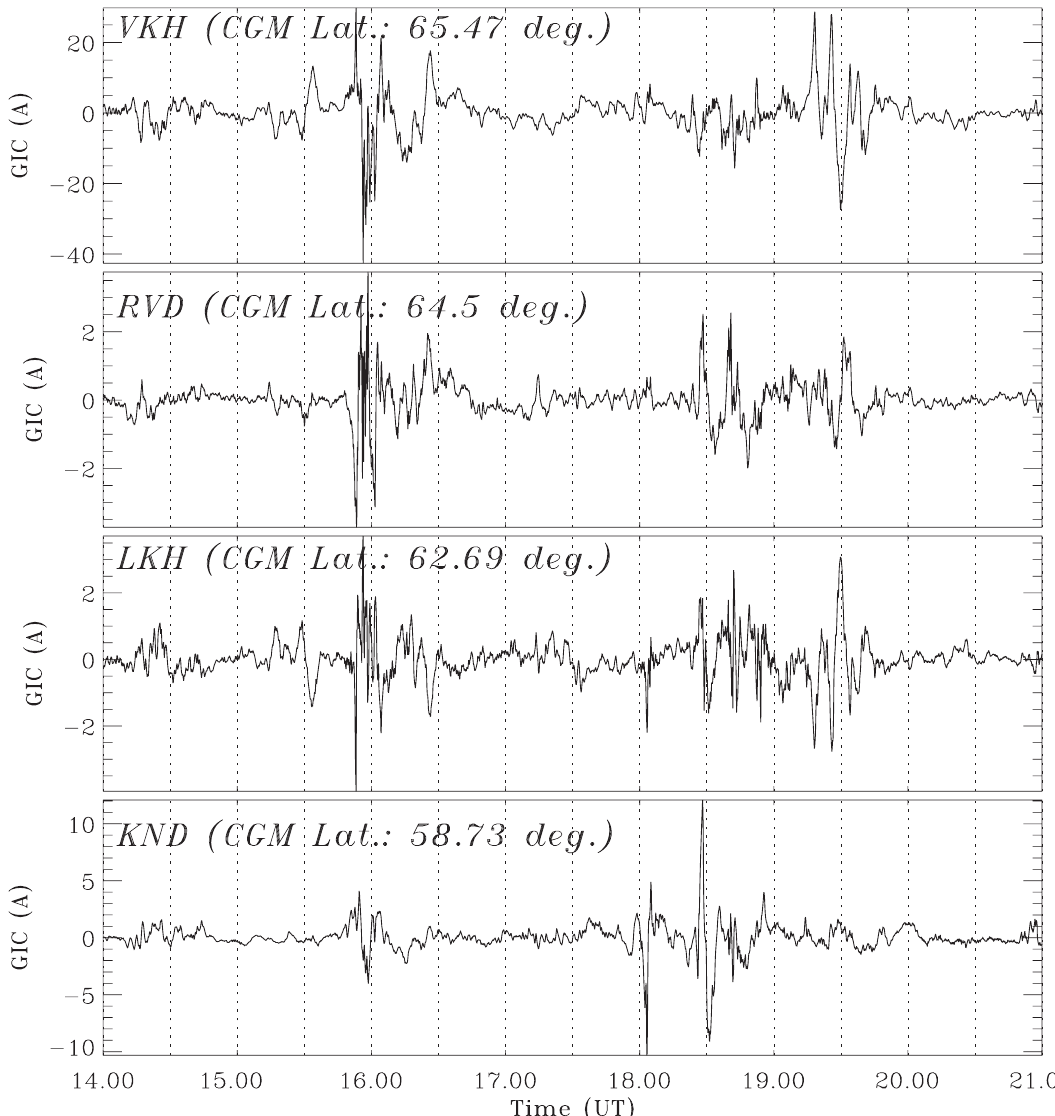
Fig. 7. GIC [A] recorded at stations VHD, RVD, LKH, and KND (10-s data) during the March 17, 2013 magnetic storm. Corrected geomagnetic latitudes are shown near the station